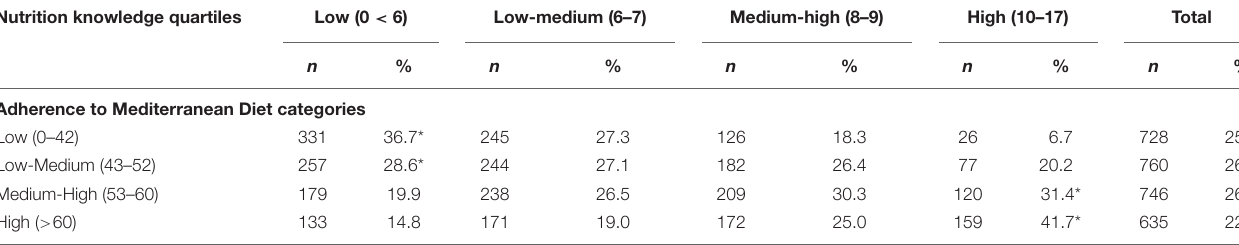
TABLE 3 | Association between nutrition knowledge and Adherence to Mediterranean Diet in Italy * p < 0.05. Nutrition knowledge